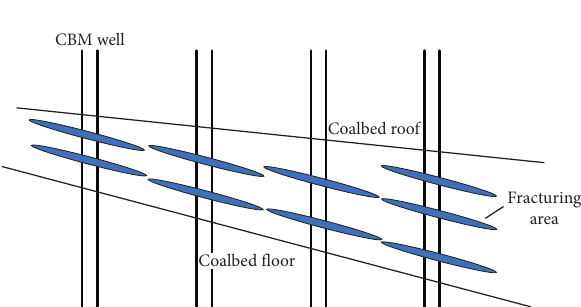
Figure 2: A sketch map of the section crossing 6# coal seam with fracturing reformation in Shengli East No. 2 Open-Pit Coal